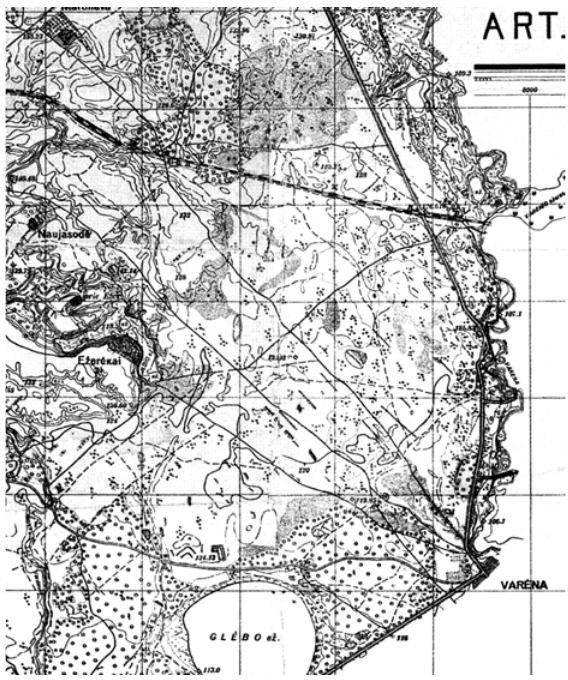
Fig. 6. Fragment of topographic map of poligon of Varėna